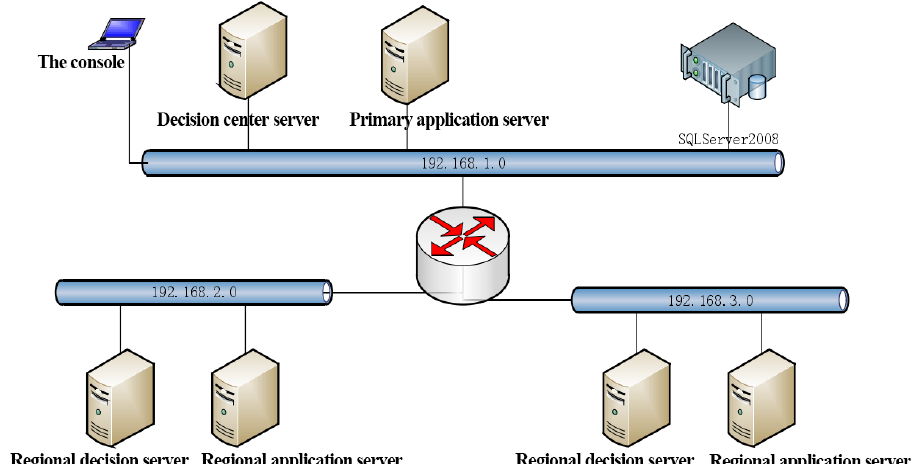
Figure 11. Server